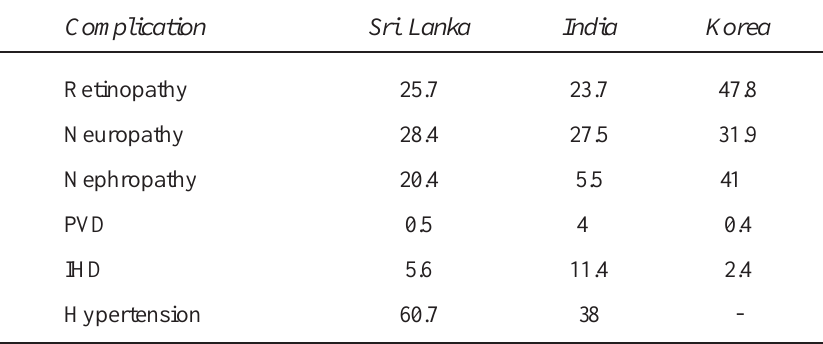
Table 3. Comparison of Sri Lankan data with other countries